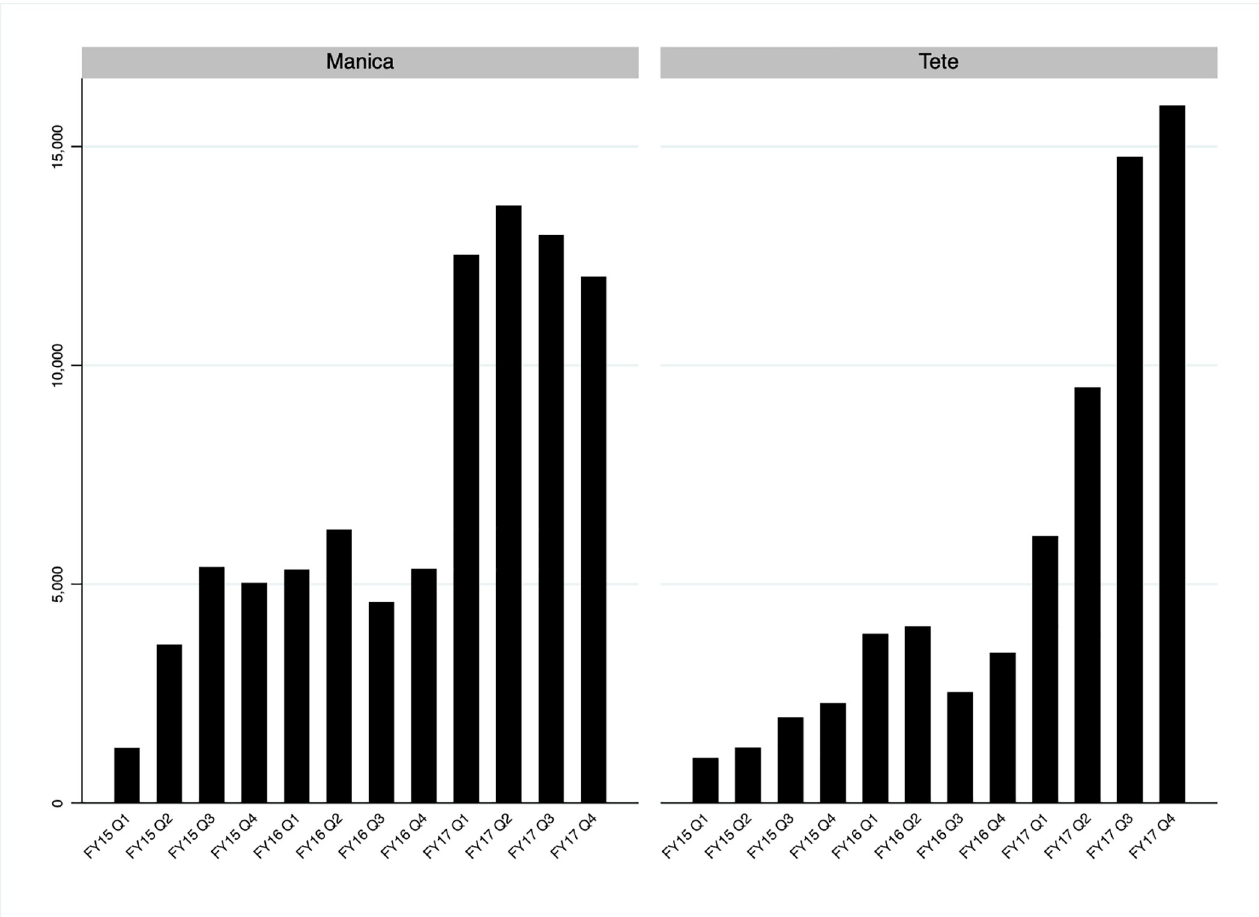
Fig 1. Voluntary medical male circumcisions (VMMCs) performed in Manica and Tete, Mozambique FY15 Q1- FY17 Q4. Fiscal year (FY) refers to the fiscal year of the United States Government which begins on October 1 and ends on September 30. The fiscal year is designated by the calendar year in which it ends–e.g., fiscal year 2015 begins on October 1, 2014, and ends on September 30, 2015. The four quarters of each fiscal year (Q1-Q4) are October-December, January-March, April-June, and